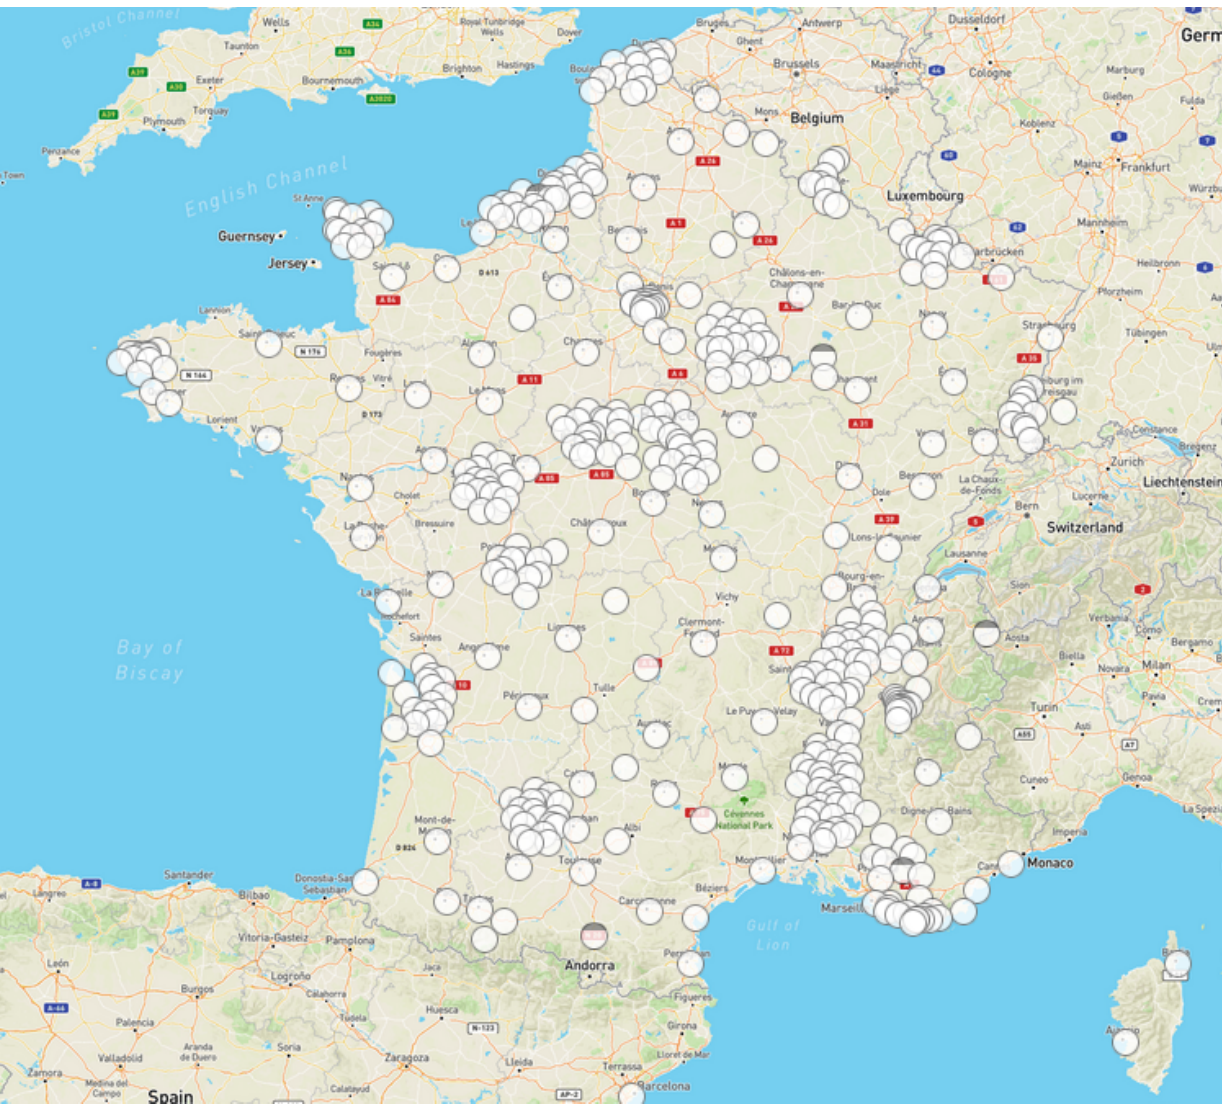
Figure 4. Téléray ambient gamma dose rate network, © Open StreetMap contributors. Distributed under the Open Data Commons Open Database License (ODbL)